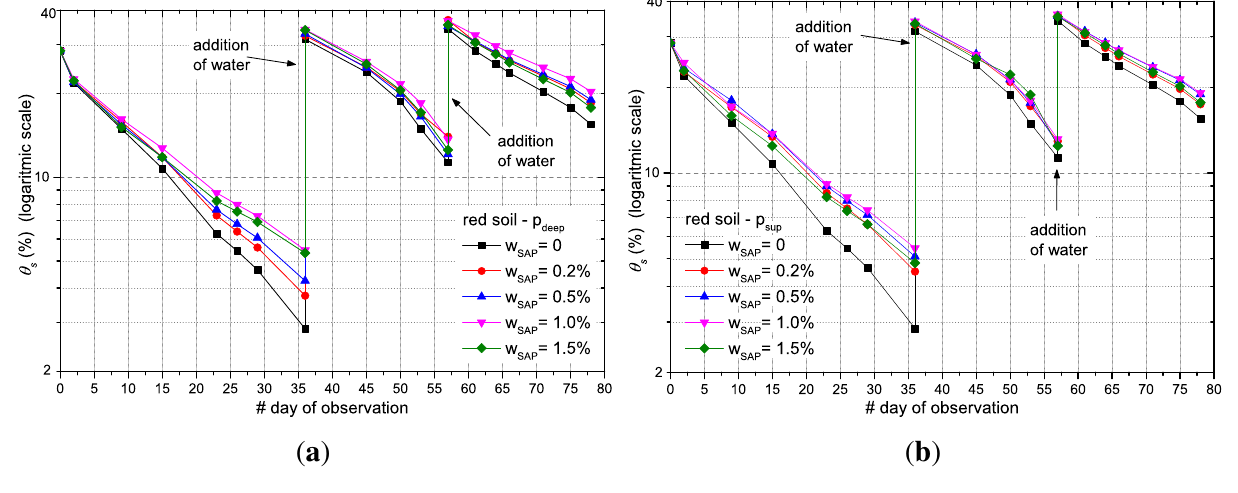
Figure 4. Variation of the moisture content of the red soil during the 78-day observation time: for p ( a ) and p ( b ) samples, with different percentages of deep sup